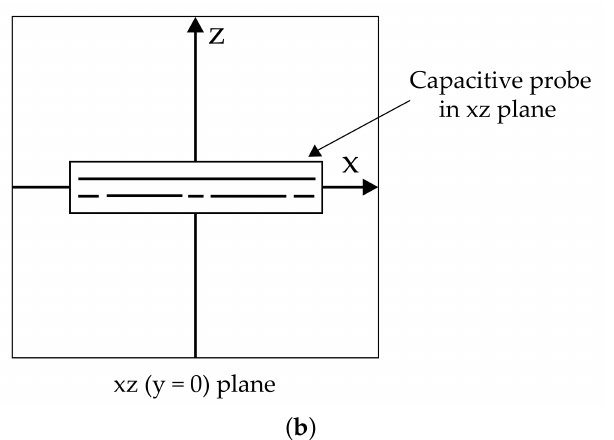
Figure 4. ( a ) xz ( y = 0) plane along the long axis of the capacitive probe symmetry, and ( b ) schematic plane coordinate system for xz cross-section.